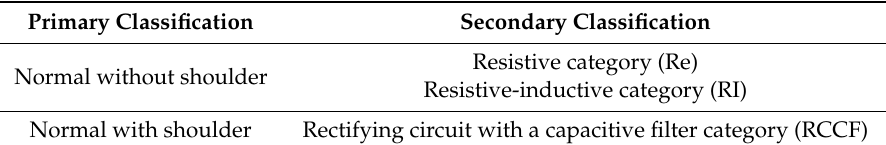
Figure 8. The phase difference for the two categories of loads. Table 2. Category recognition.